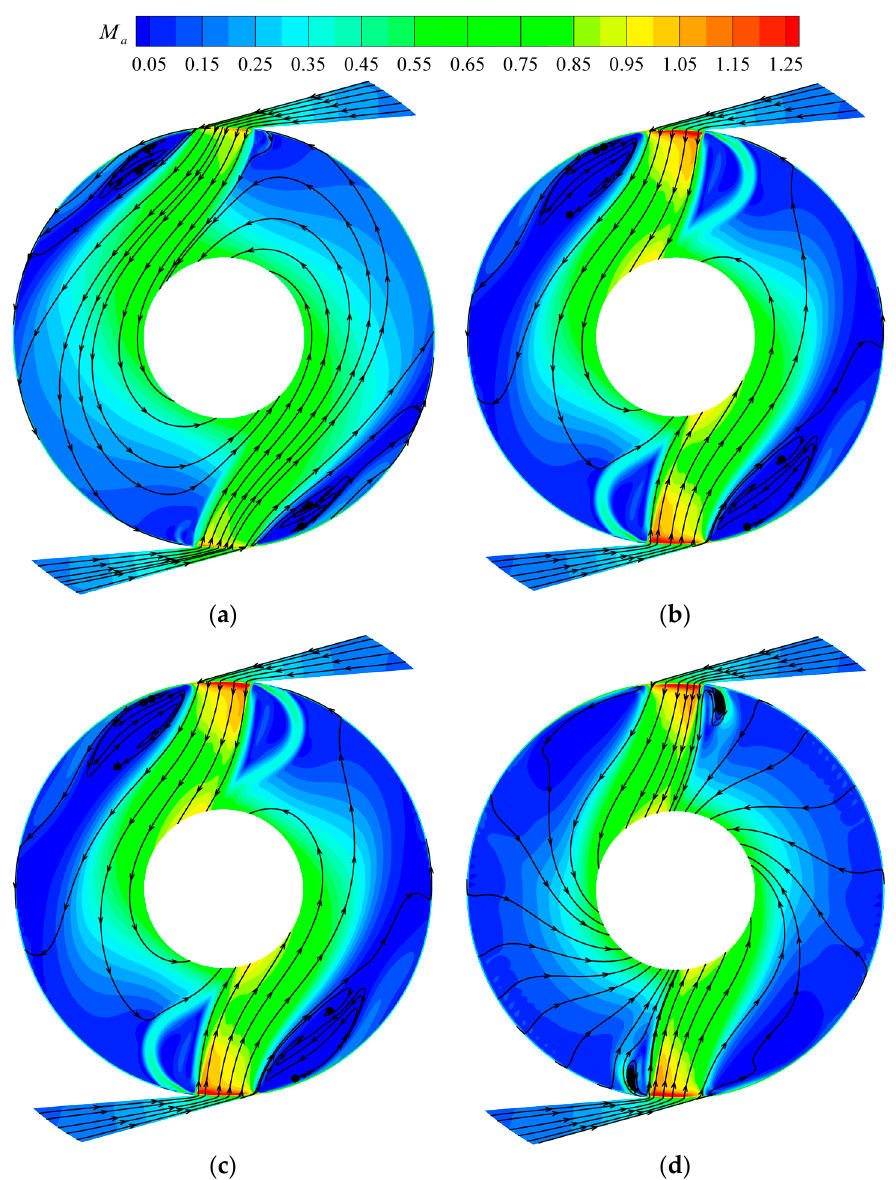
Figure 12. Mach number contours and streamlines on the mid-sections of DCs 1 and 3 for the one-to-many turbine cases with different disc thickness at 30,000 r/min: ( a ) DC1 for Case 1-0.5; ( b ) DC1 for Case 2-0.5; ( c ) DC3 for Case 1-0.5; and ( d ) DC3 for Case 2-0.5.